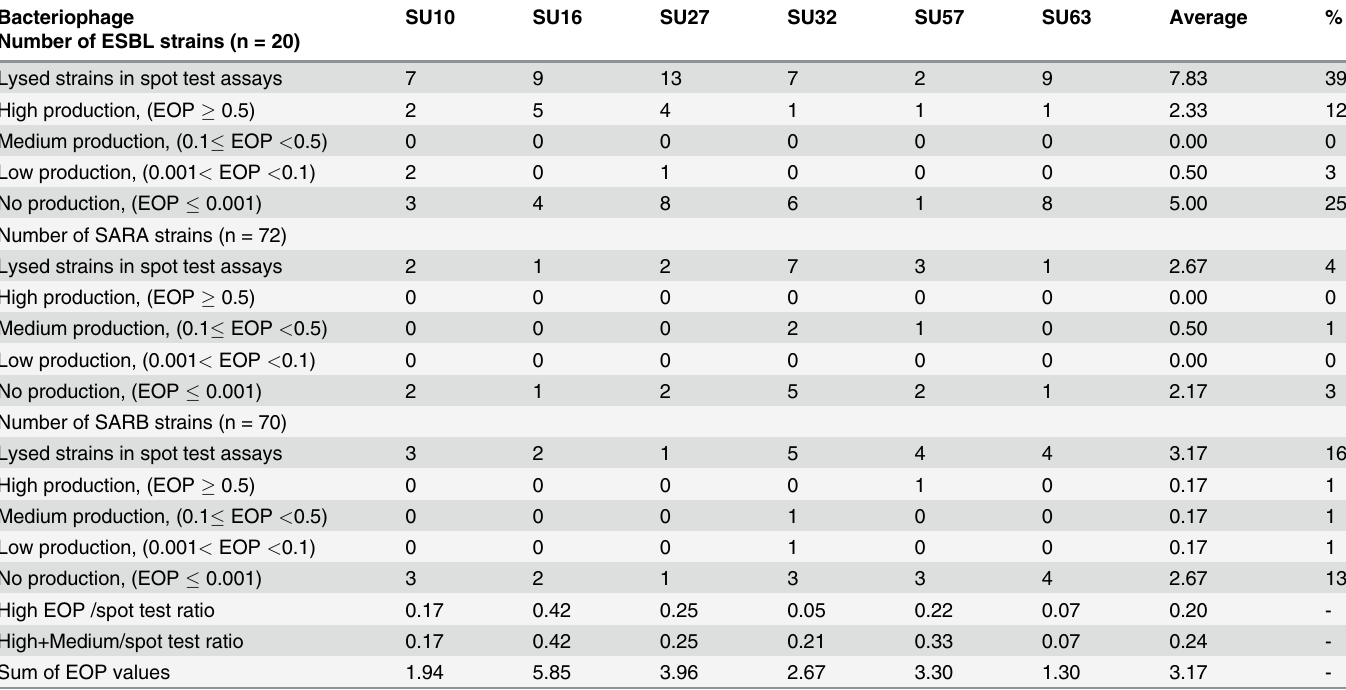
Table 3. Results of spot test assays and ef fi ciency of plating (EOP) on ESBL- E . coli , SARA, and SARB strains. Bacteriophage